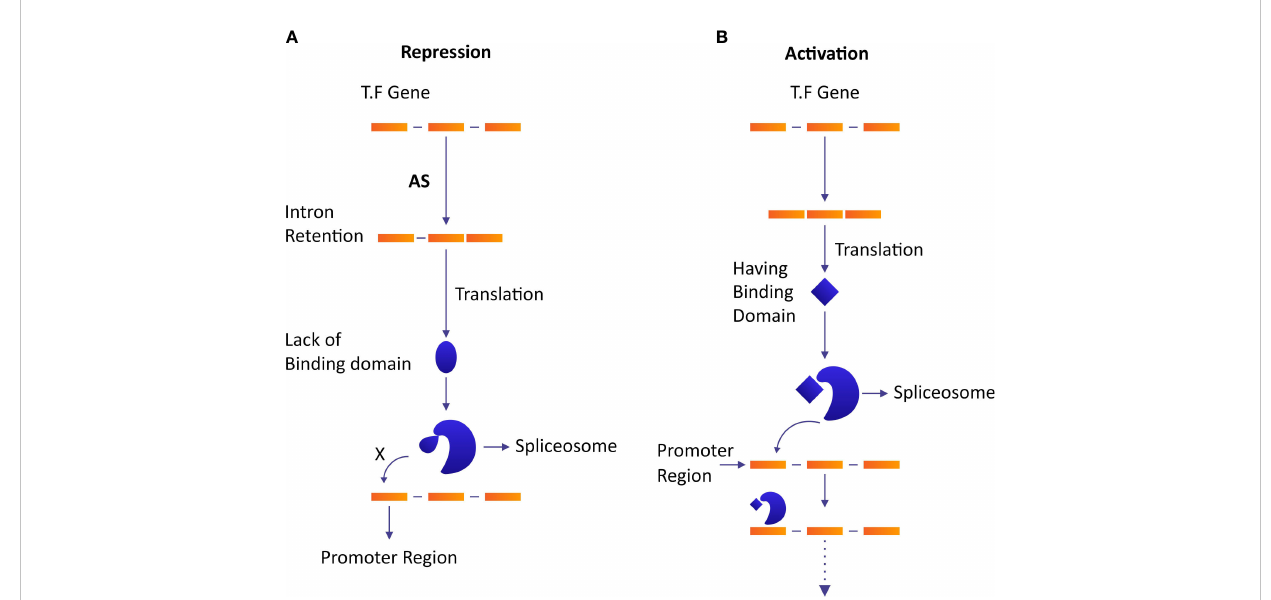
FIGURE 4 The role of AS in the repression and activation of the transcriptional regulatory network. Homodimers increase the DNA-binding speci fi city and af fi nity of TFs, while heterodimers diversify the af fi nities and speci fi cities of TFs. (A) AS causes a modi fi cation of the structure of TF due to intron retention and changes its binding ability which results in an inhibition of the binding of spliceosome complex and represses the regulation of gene expression. (B) The activation of GTN in absence of